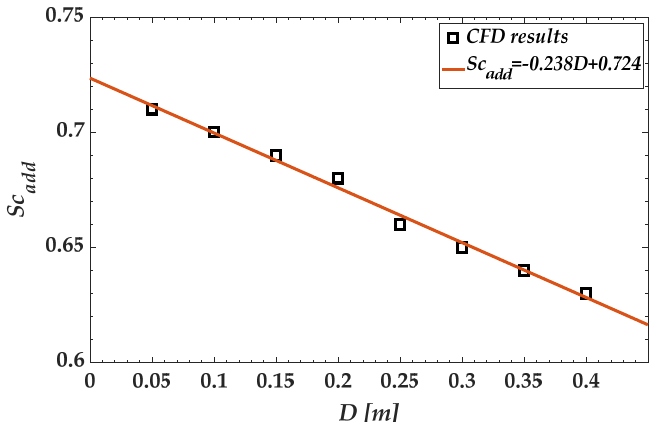
Figure 7. Relationship between valid turbulent Schmidt number and nozzle diameter of additional variable.